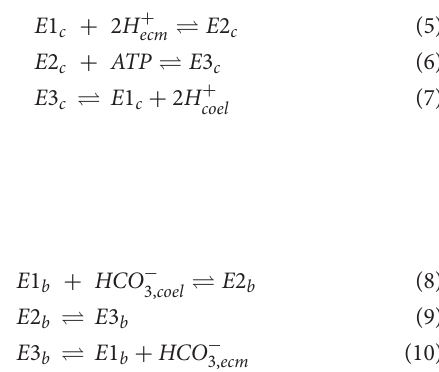
Frontiers in Marine Science |